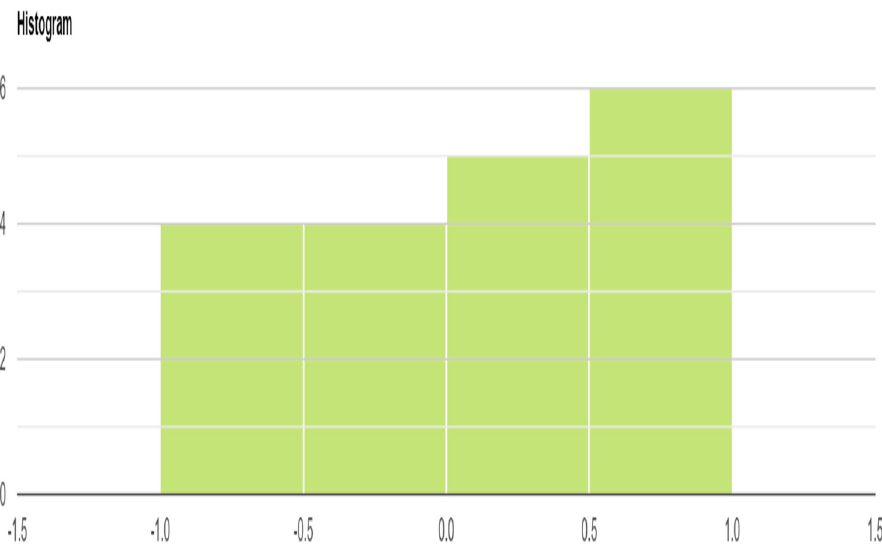
Figure 1. Clusters of budget balances influence the government debt ratio . Note: the number of member states on the y-axis and the four clusters [ − 1.0; 1.0] on the x -axis are based on the correlation member states on the y ‐ axis and the four clusters [ − 1.0; 1.0] on the x ‐ axis are based on the correlation coefficients.